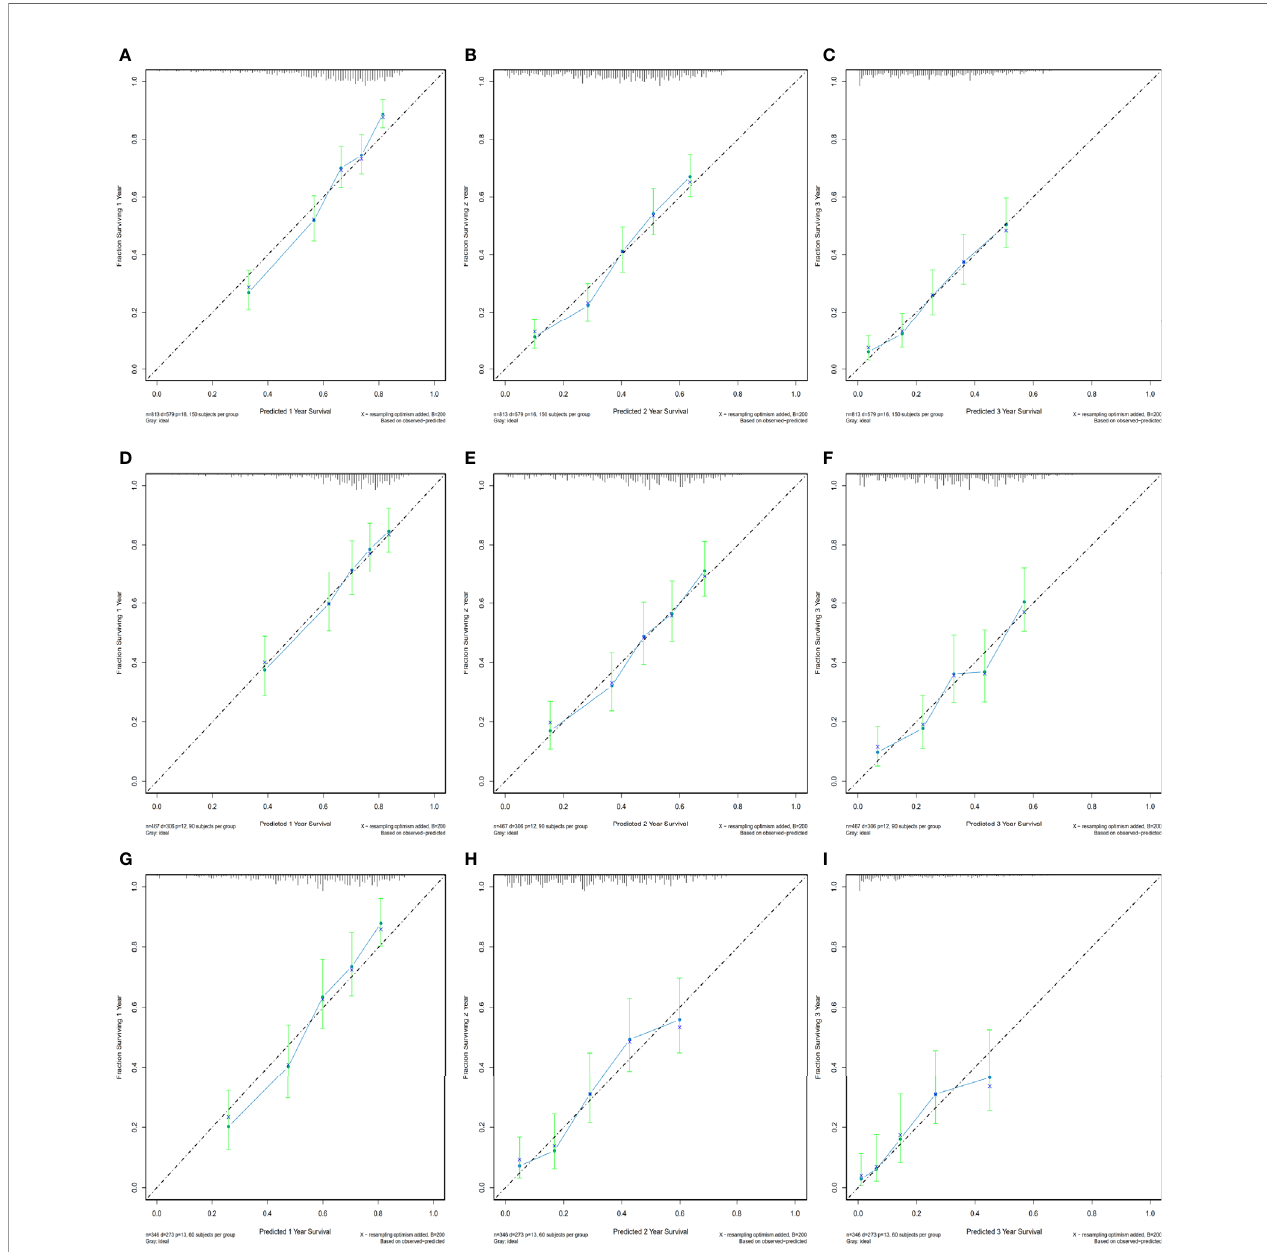
FIGURE 3 | Bootstrap calibrations of the nomograms in the training cohorts. Bootstrap calibrations of the nomograms for predicting (A) 1-year CSS, (B) 2-year CSS, and (C) 3-year CSS in PDAC group; (D) 1-year CSS, (E) 2-year CSS, and (F) 3-year CSS in the PHC group; and (G) 1-year CSS, (H) 2-year CSS, and (I) 3-year CSS in the PBTC group. The predictions were well correlated with the actual survival